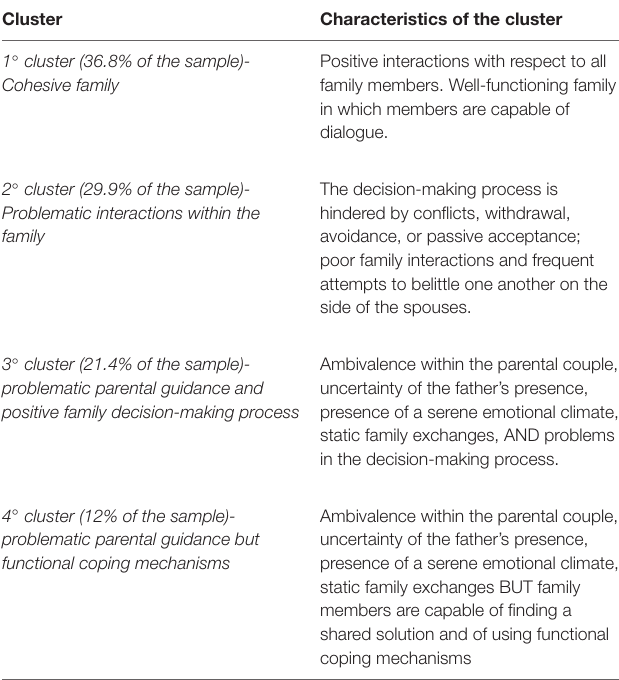
TABLE 4 | Cluster analysis on the process indicators.